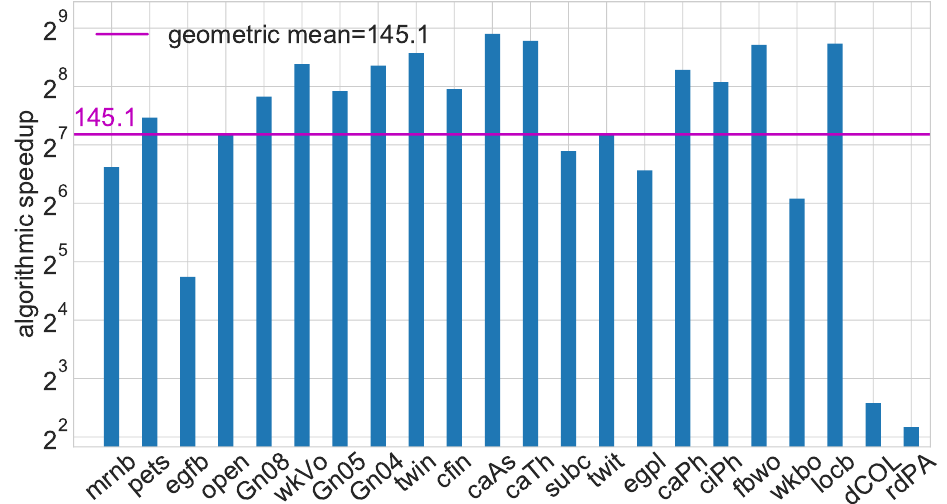
Figure 6. The running time speedup of KADABRA over RK for all the instances in the evaluation set for 4375.0. Every bar is the ratio of the arithmetic means for 5 repeated runs per instance. The smallest speedup is 6.0 for instance dimacs9-COL (dCOL) and the largest speedup is 478.7 for instance ca-AstroPh (caAs). The geometric mean for all speedups is around 159.3. Instances are sorted by their number of nodes and the y -axis is in log